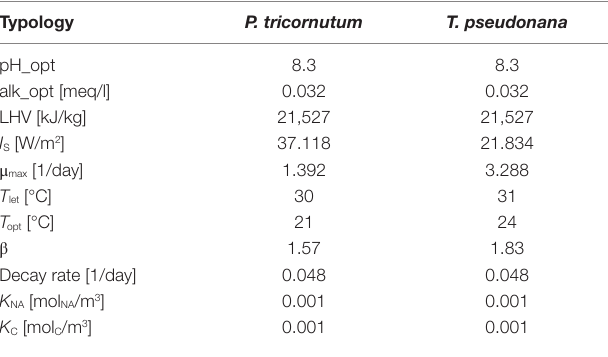
TaBle 3 | Microalgae species